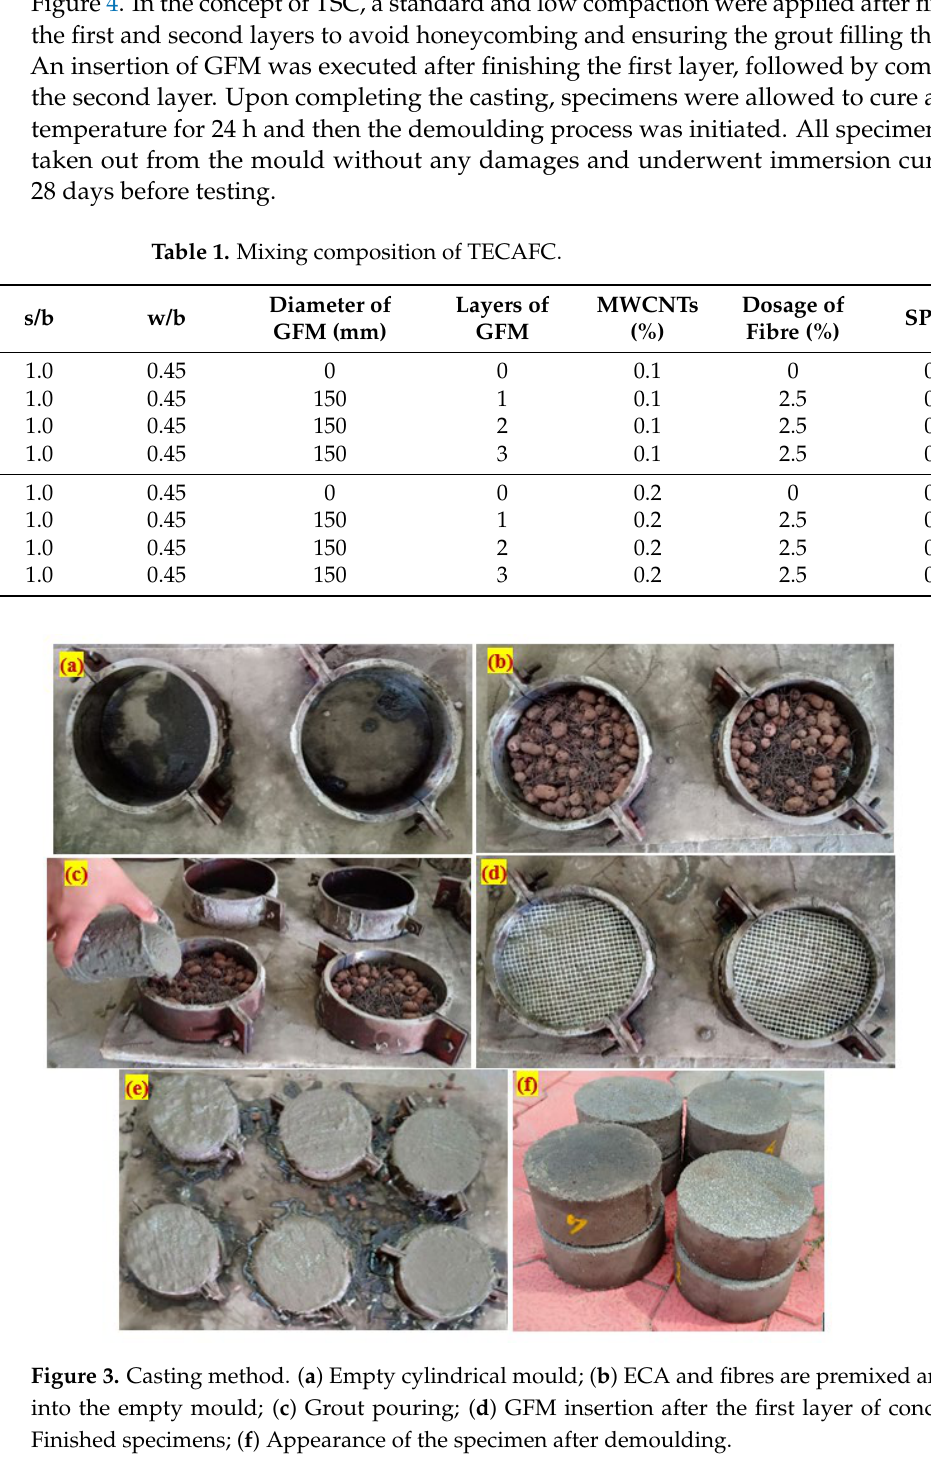
Figure 4. MWCNT mixing method to develop grout. 2.4. Testing Setup ACI Committee 544 [21] falling weight impact was conducted to assess the resistance of TECAFC specimens against impact. It is essential to highlight that the test procedure is very simple and easy to perform, where measurements of time history, vibration and de- formations are not required. It is only required to record the numbers of impacts that cause the first surface crack and failure of the test specimen. Figure 5 illustrates the simple